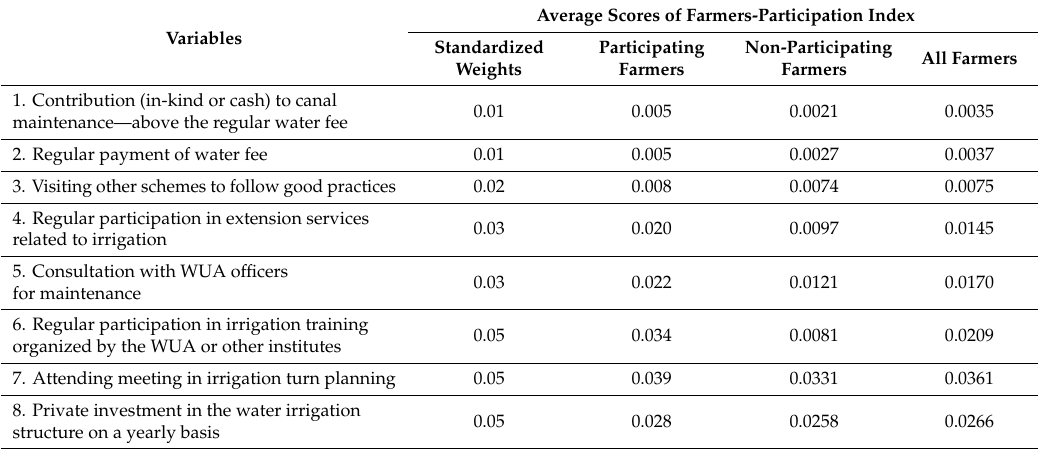
Table 2. Summary table of Farmers Participation Index survey in the Mubuku irrigation scheme, N = 122